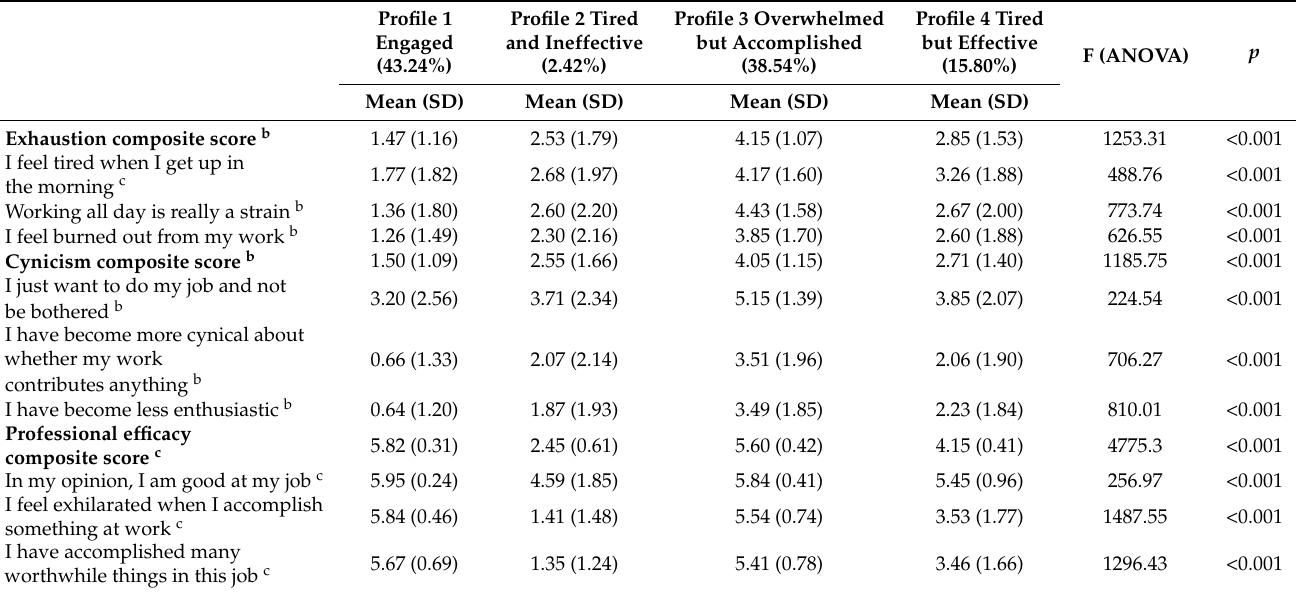
Table 2. Burnout scores and individual items by profile membership a ( n =